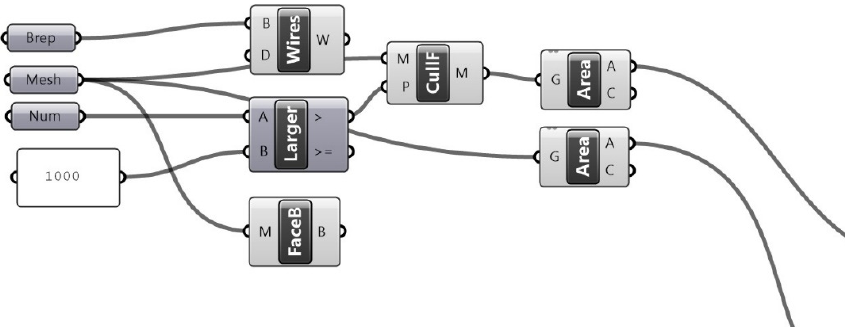
Figure 10. Area with Less than a 1000 Lux Algorithm.